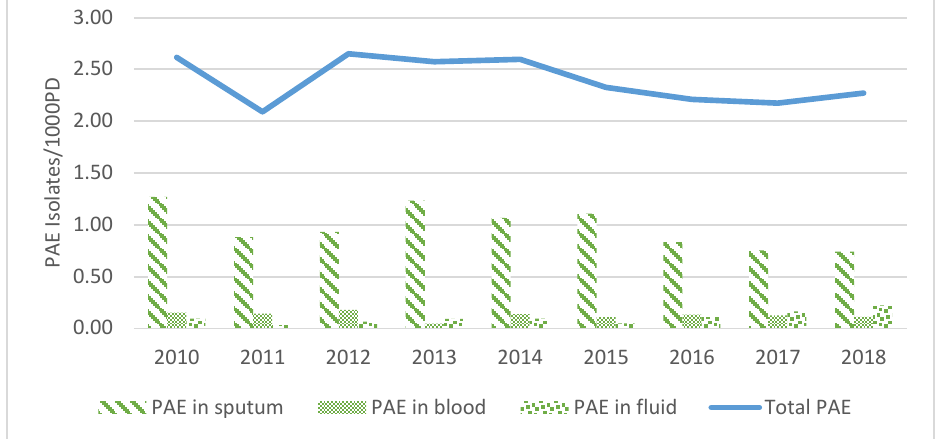
Figure 2. Pseudomonas aeruginosa trend from 2010 to 2018 by specimen type, per 1000 PD. The changes in isolation density from other cultures were not statistically significant.